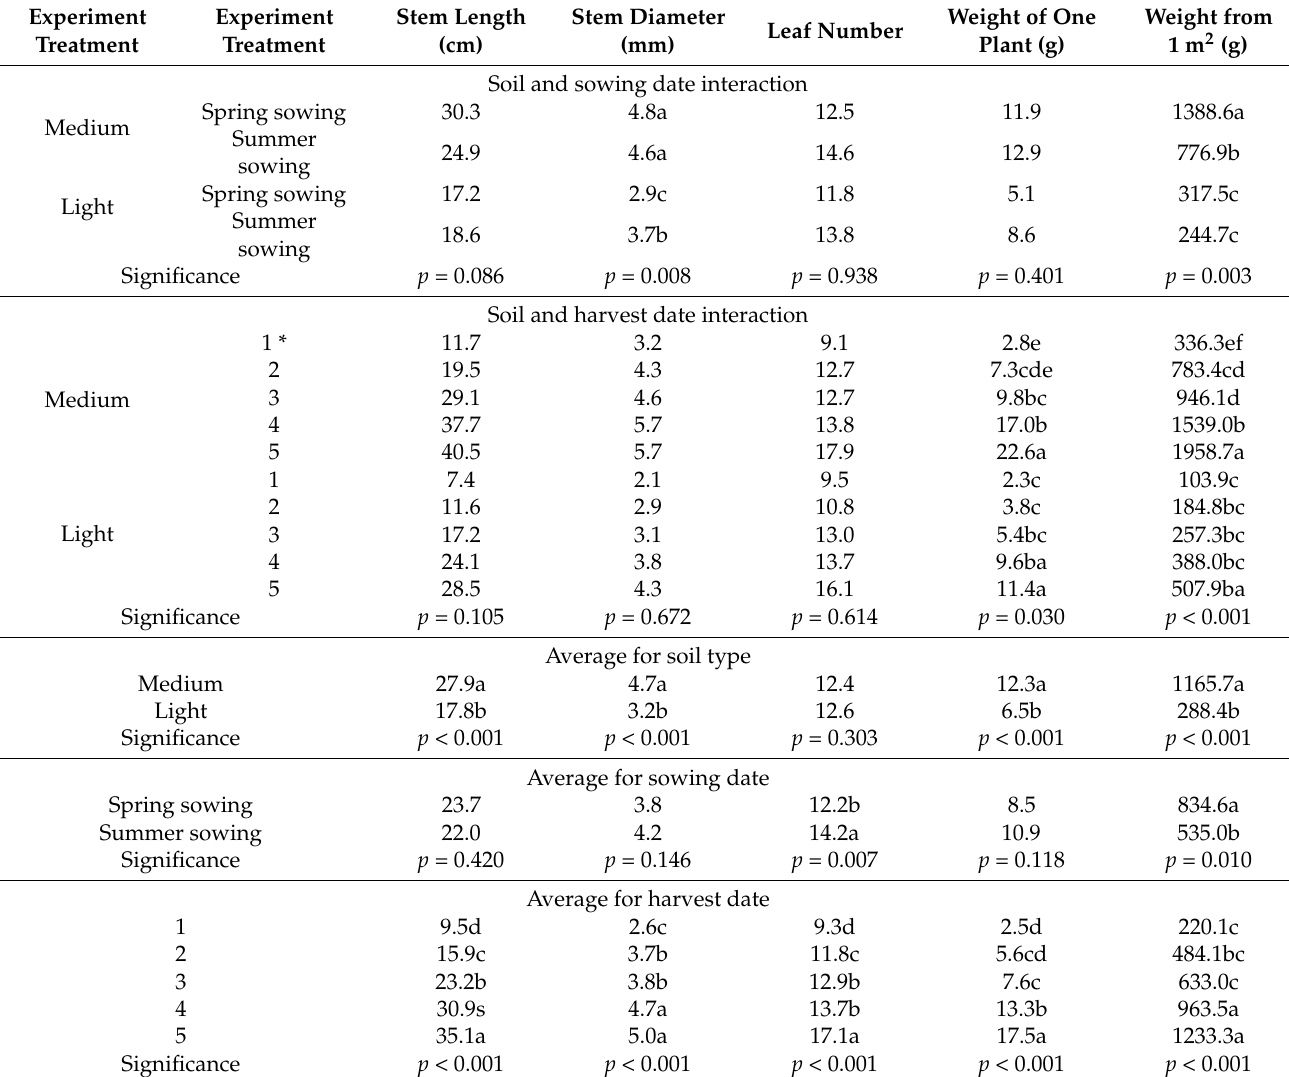
Table 4. The effect of soil type, sowing date and harvest date on quinoa biometrics parameters and biomass yield. Average from years